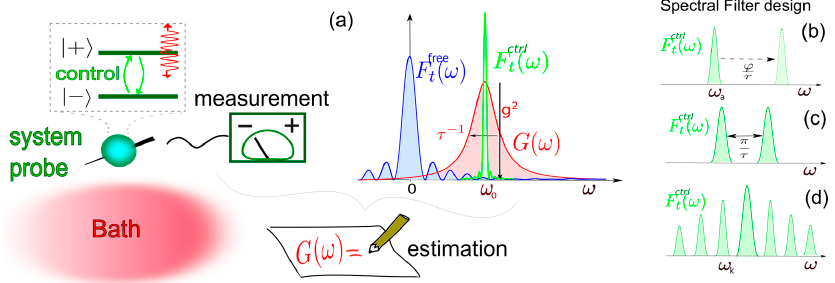
Figure 1. ( a ) Probing bath-induced decoherence by a system probe that is subject to control. Key bath parameters that define the bath spectrum G ( ω ) , such as the correlation time τ and the bath-coupling g, are estimated from measurements of the probe in the (anti-)symmetric superposition states. Spectral Filters F t ( ω ) designed by: ( a ) Free evolution (blue sinc filter function), and Car-Purcell-Meiboom-Gill (CPMG) sequence control (green narrow band pass filter); ( b ) Modulation with small phase shifts, ϕ (cid:28) 1; ( c ) π -pulses ( ϕ = π ) modulation; ( d ) Quasi-periodic